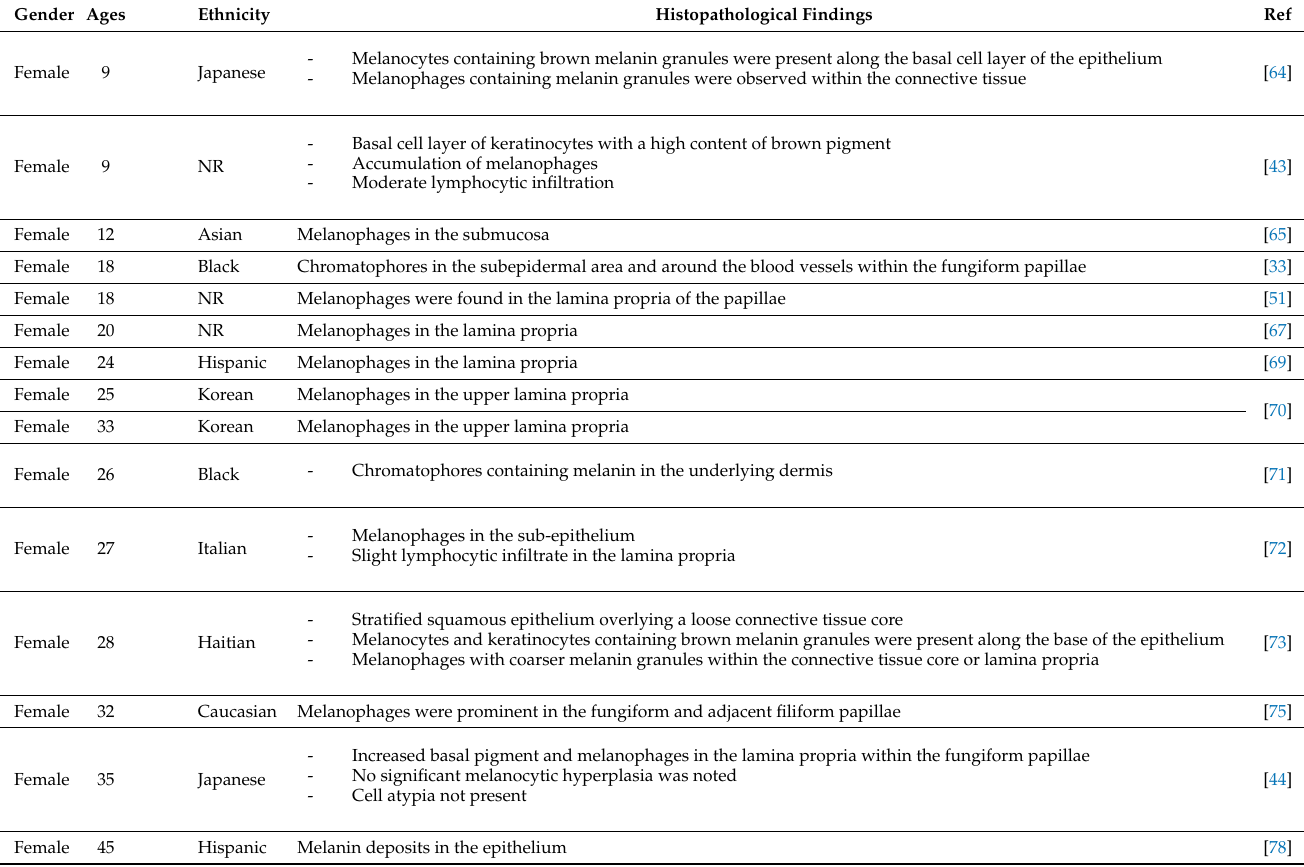
Table 2. Histopathological findings in the reported cases of selected studies. Histopathological